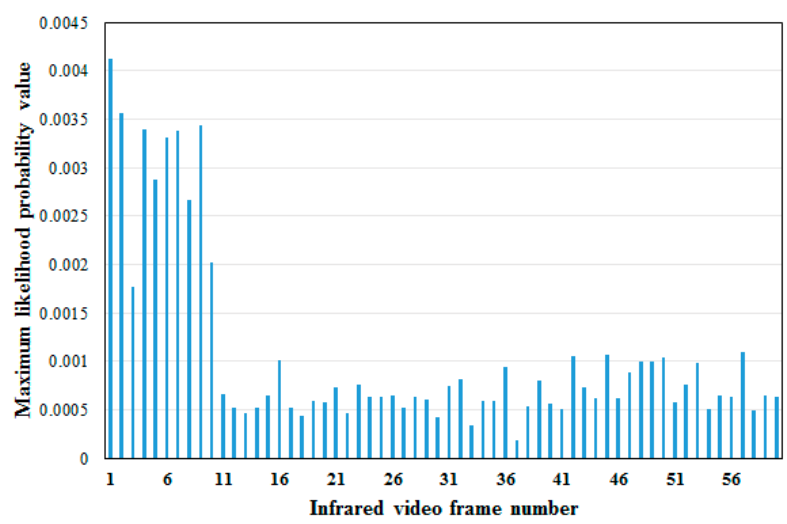
Figure 14. Maximum likelihood probability value of confidence map in the tracking process.